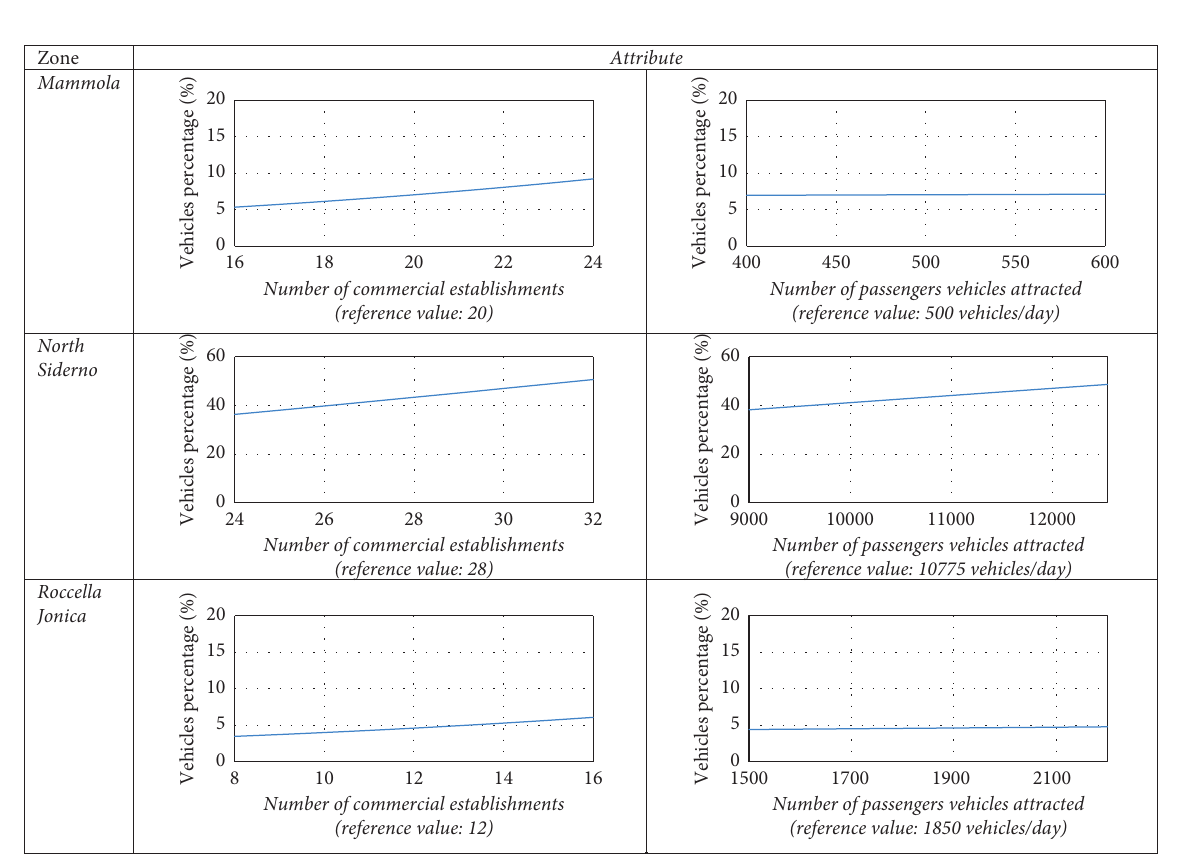
Figure 5: Probability of zonal acquisition (or percentage of freight vehicles having a zone as destination) estimated by model 6. Examples for zones of Mammola, Siderno, and Roccella